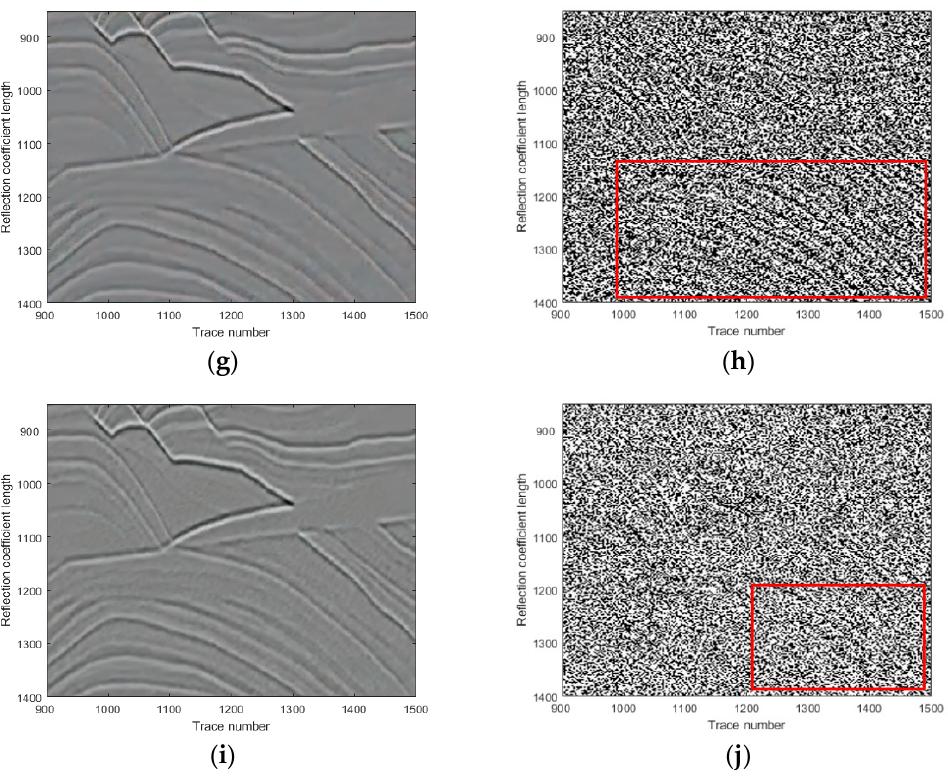
Figure 8. Denoising results of the seismic data synthesized by the Marmousi2 model (calculated by the convolution model). The red rectangle marks the parts with distinct differences in the difference profiles among each method. ( a ) Clean data; ( b ) Noisy data; ( c ) Denoised image through the pre-trained model; ( d ) The difference profiles between noisy data ( b ) and pre-denoised data ( c ); ( e ) Denoised data through the proposed method; ( f ) The difference profiles between noisy data ( b ) and denoised data ( d ); ( g ) Denoised data through the DnCNN; ( h ) The difference profiles between noisy data ( b ) and denoised data ( g ); ( i ) Denoised data through the U-net; ( j ) The difference profiles between noisy data ( b ) and denoised data ( i ).